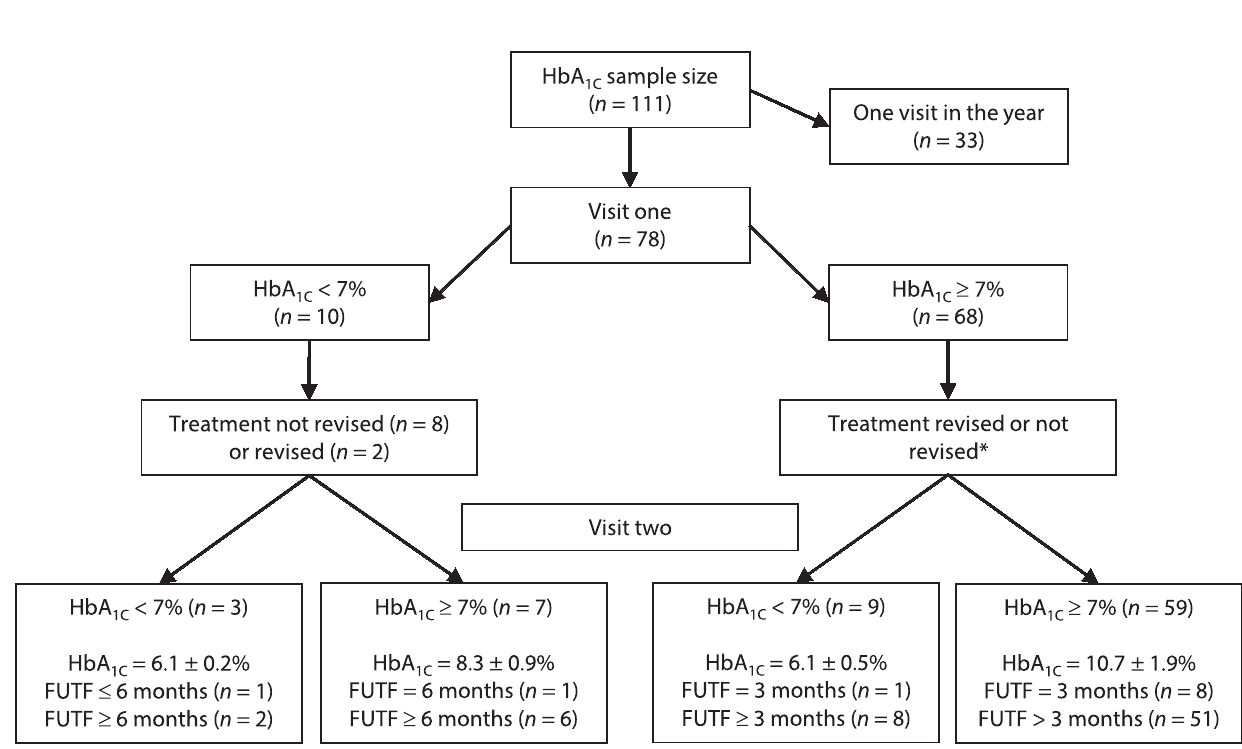
Figure 1: Flow diagram of patients treated and monitored using HbA1c levels at visits 1 and 2. *According to SEMDSA 2009